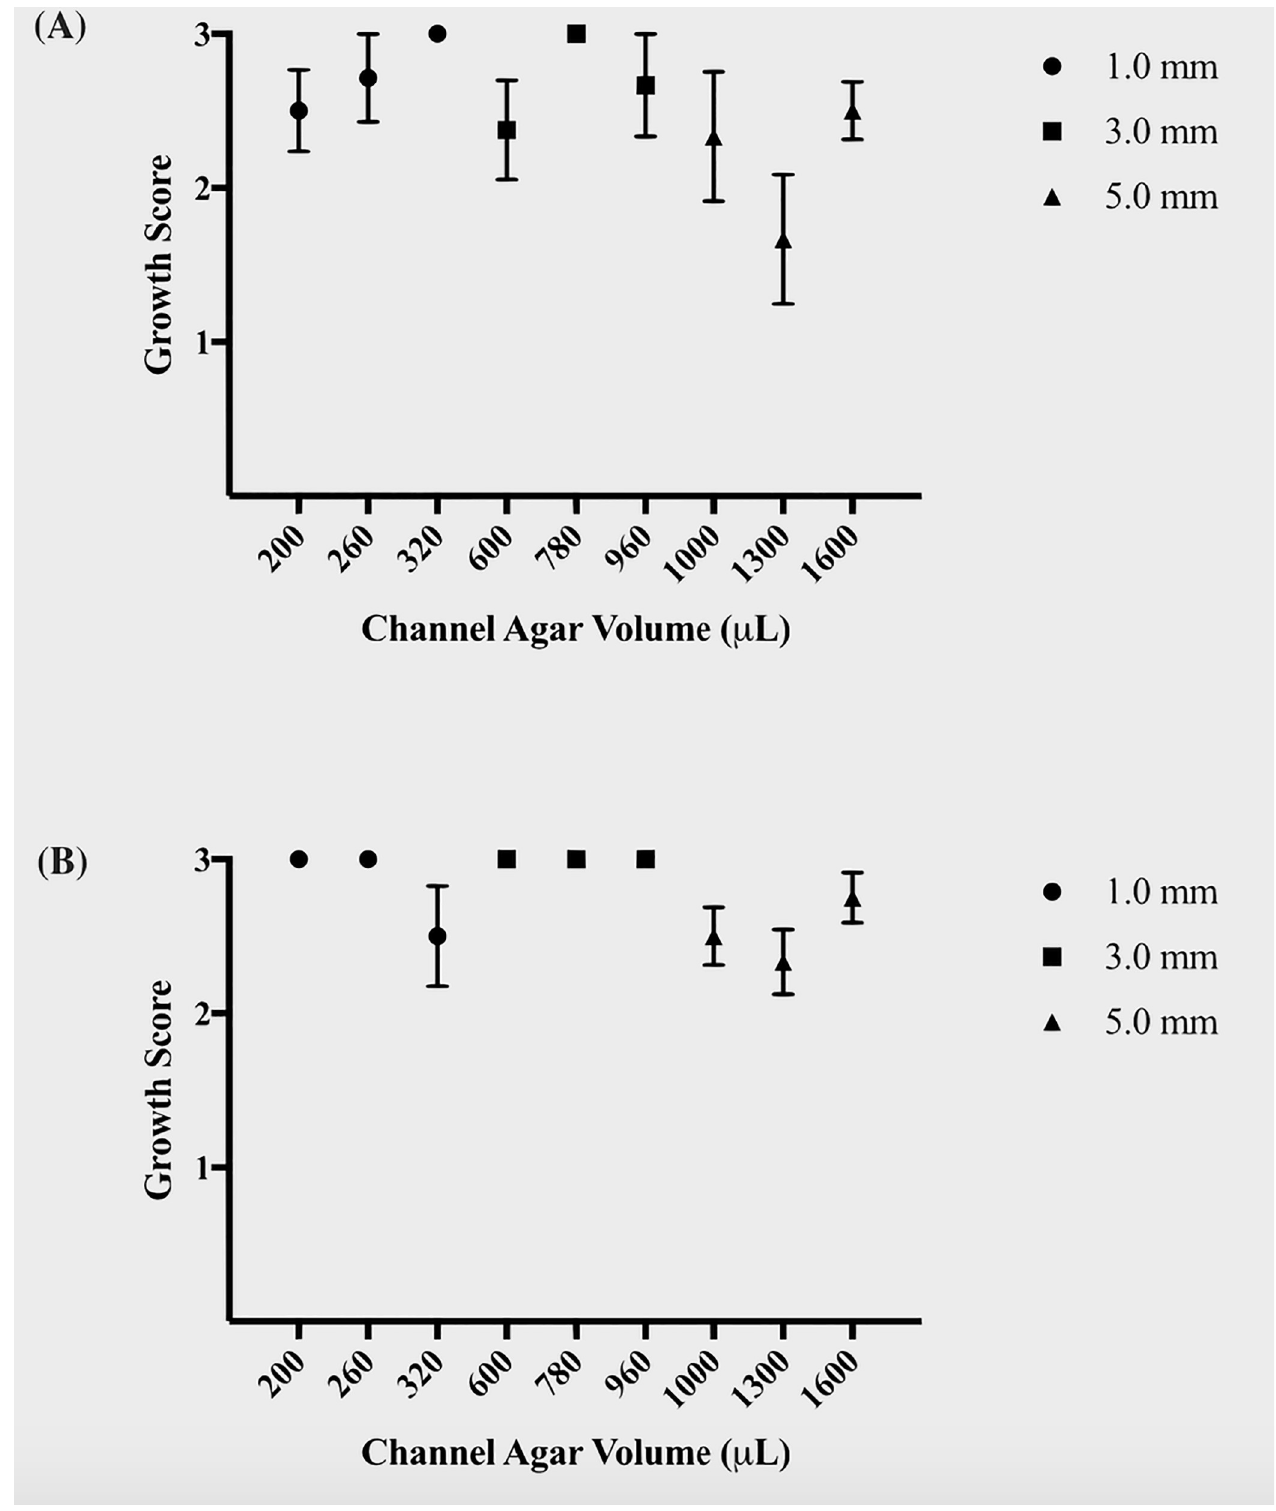
Fig 4. Growth scores for pipet and razor-blade microbial inoculation methods. The tables show the mean growth score with SEM bars for microbes inoculated via (A) pipet-inoculation and (B) razor blade-inoculation across different agar volumes. Note the increased number of channels that exhibited a uniform, flat growth front (Score 3) when inoculated via the latter method.